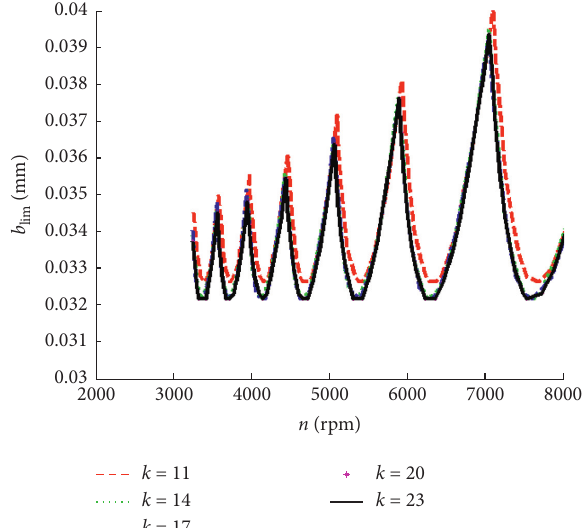
Figure 7: Different approximate numbers of terms effect on chatter